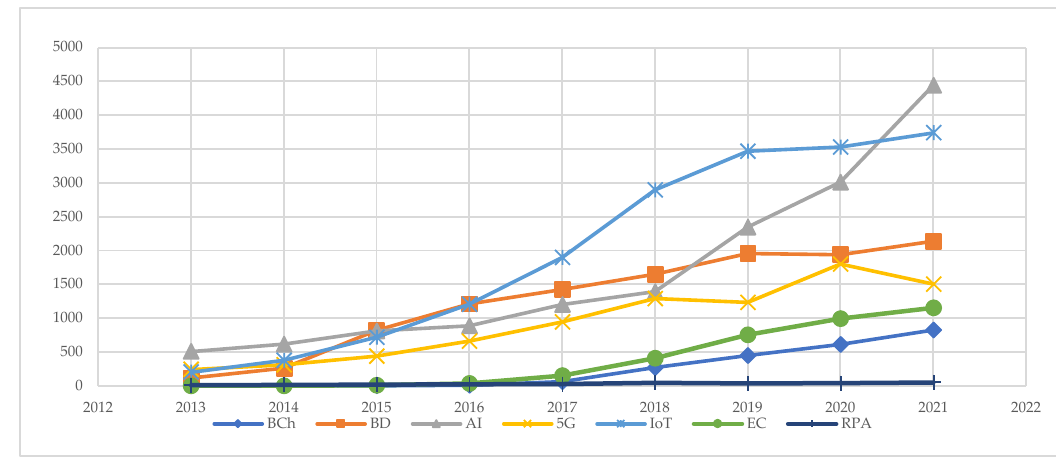
Figure 4. Publications analysis on emerging technologies from 2013 to 2021.